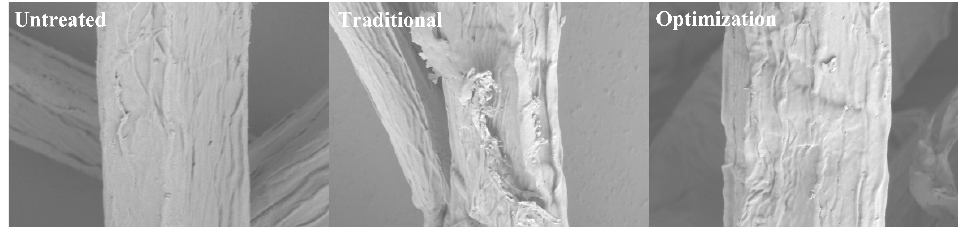
Figure 5. Morphological changes of pulp under different chlorine dioxide oxidation conditions.